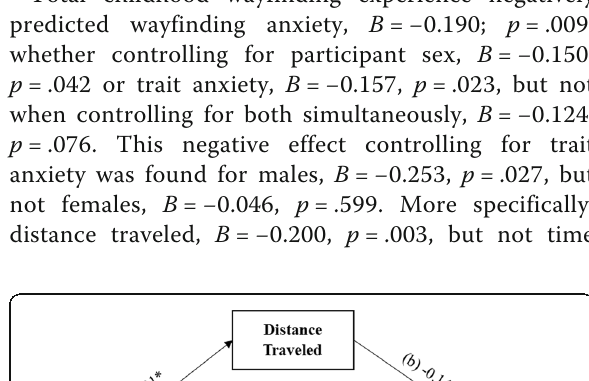
Fig. 5 Direct and indirect effects of participant sex on wayfinding anxiety through the mediator distance traveled, controlling for trait anxiety. * p < .05, ** p < .01, *** p < .001